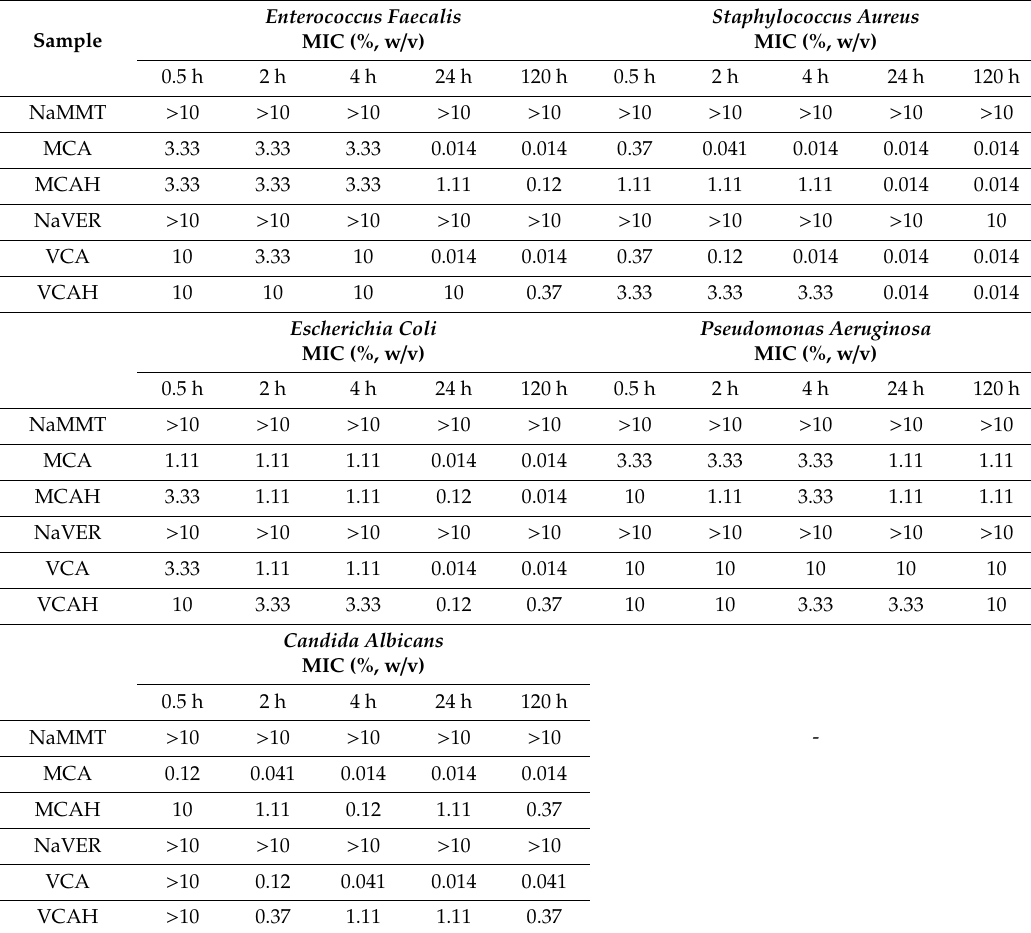
Table 2. The MICs (%, w / v) of prepared samples against the di ff erent bacterial strains.